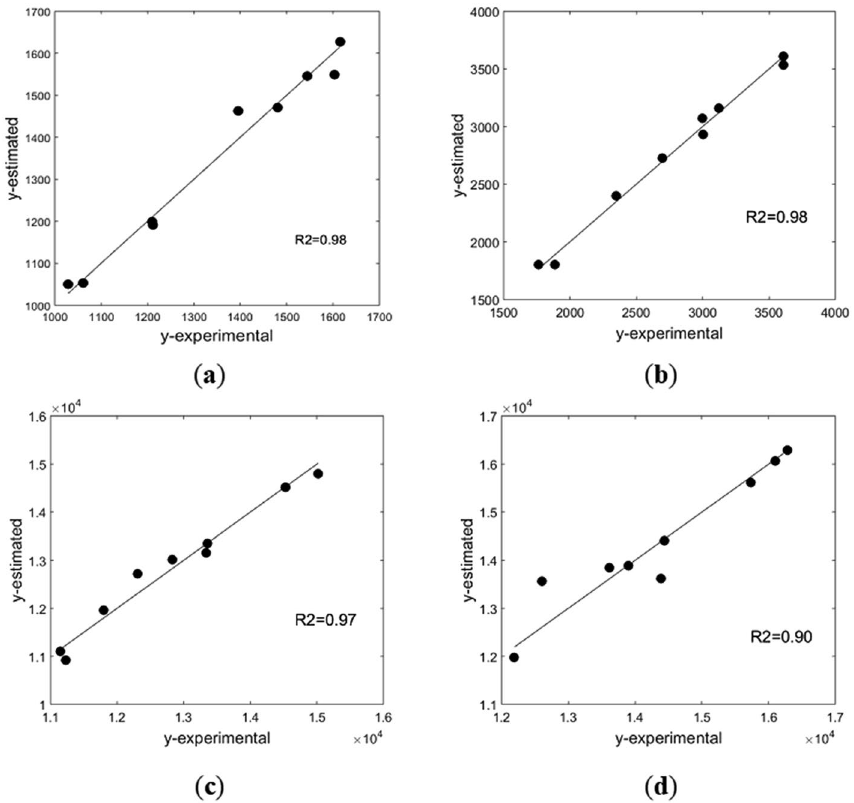
Figure 5. Model-experiment parity plots in various solvents: ( a ) water; ( b ) 25% ethanol; ( c ) 50% ethanol; ( d ) 70% ethanol.